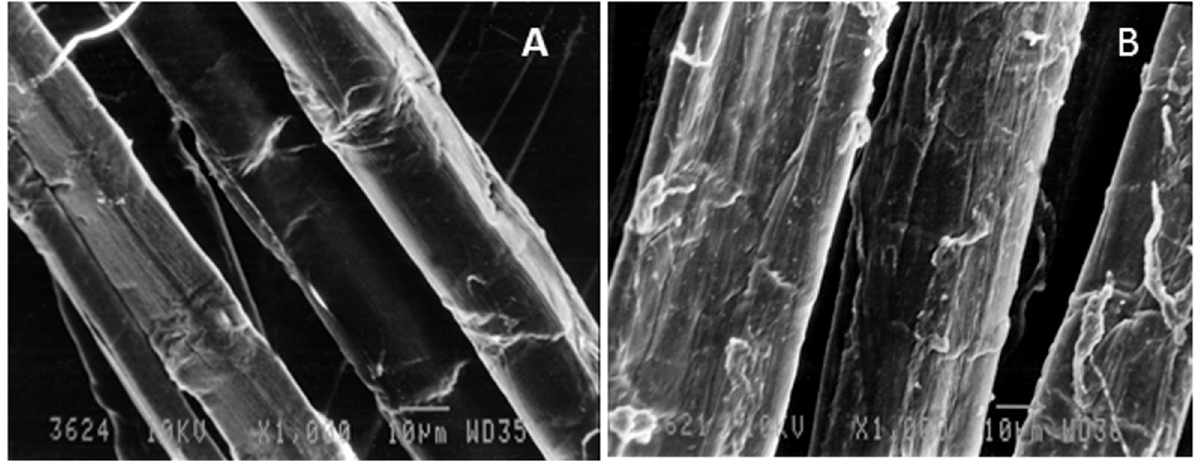
Figure 5. Scanning electron micrographs of (A) P-C and (B) P-X-L-C treated ONP pulp. doi:10.1371/journal.pone.0072346.g005 PLOS ONE |